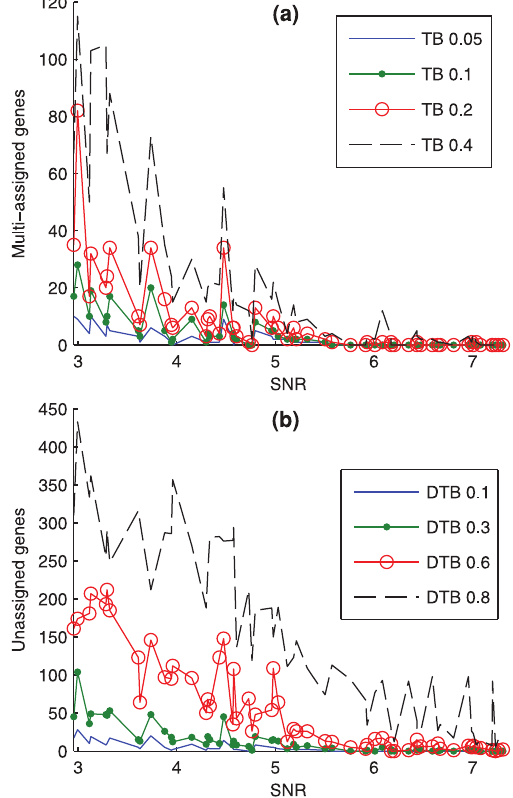
Figure 5. SNR effect over the number of multiply assigned and unassigned genes. (a) The number of multi-assigned genes is plotted over the 60 SNR values in four cases of wide clusters generated by using the TB technique. (b) The number of unassigned genes is plotted over the 60 SNR values in four cases of tight clusters generated by using the DTB technique. Note that there are no multi-assigned genes in tight clusters as there are no unassigned genes in wide clusters. Noisier datasets tend to provide wider clusters when minimising the FNI value, as wider clusters are likely to include all genes that belong to them giving rise to low false-negatives. The FPI and FNI analyses using synthetic datasets aim at validating the Bi-CoPaM method and are not provided as validation tools for real datasets.